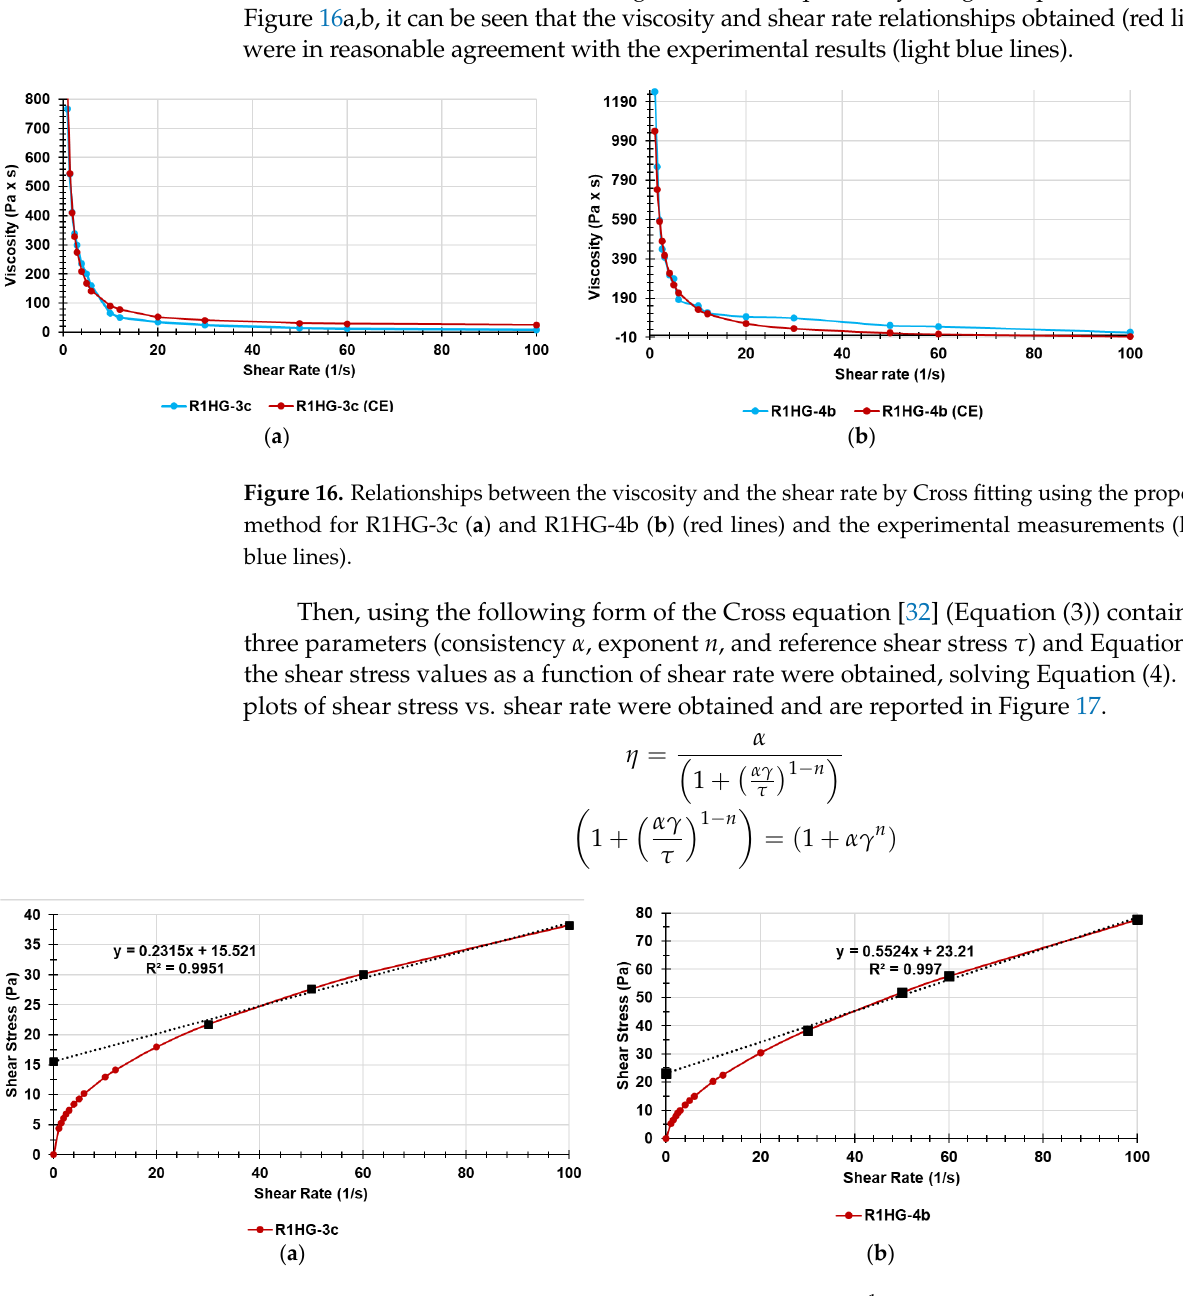
Figure 17. Plots of the shear stress ( τ , Pa) vs. shear rate ( γ , s −1 ) of R1HG-3c ( a ) and R1HG-4b ( b ). The intercept of equations associated with the linear tract of both curves provides the values of the yield stress reported in Table 7.